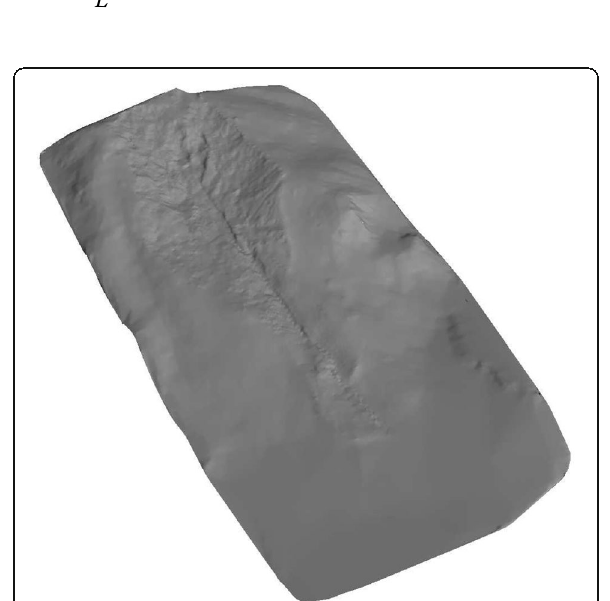
Fig. 12 Earthfill dam, built during safety operations in the landslide